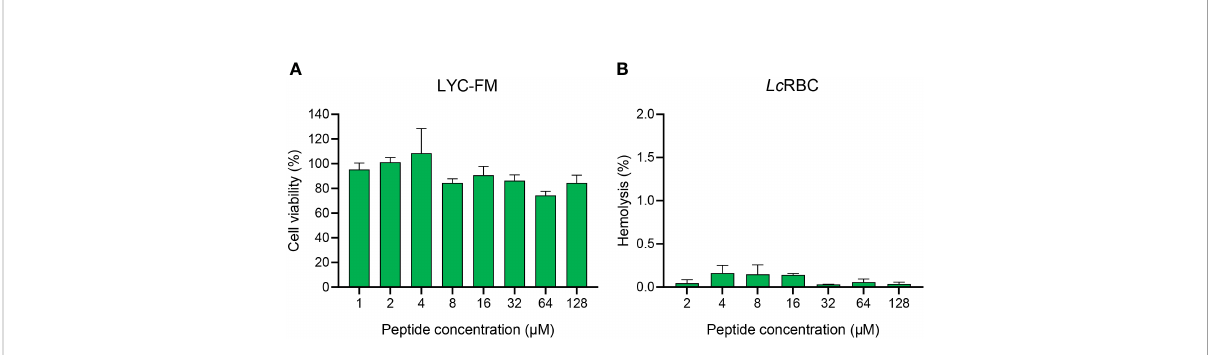
FIGURE 4 Cytotoxicity and hemolytic activity of SKL17-2. (A) Cytotoxicity of SKL17-2 against LYC-FM cells. (B) Hemolytic activity of SKL17-2 against large yellow croaker RBCs. The data are shown as the mean ± SEM of three independent experiments performed in triplicate.